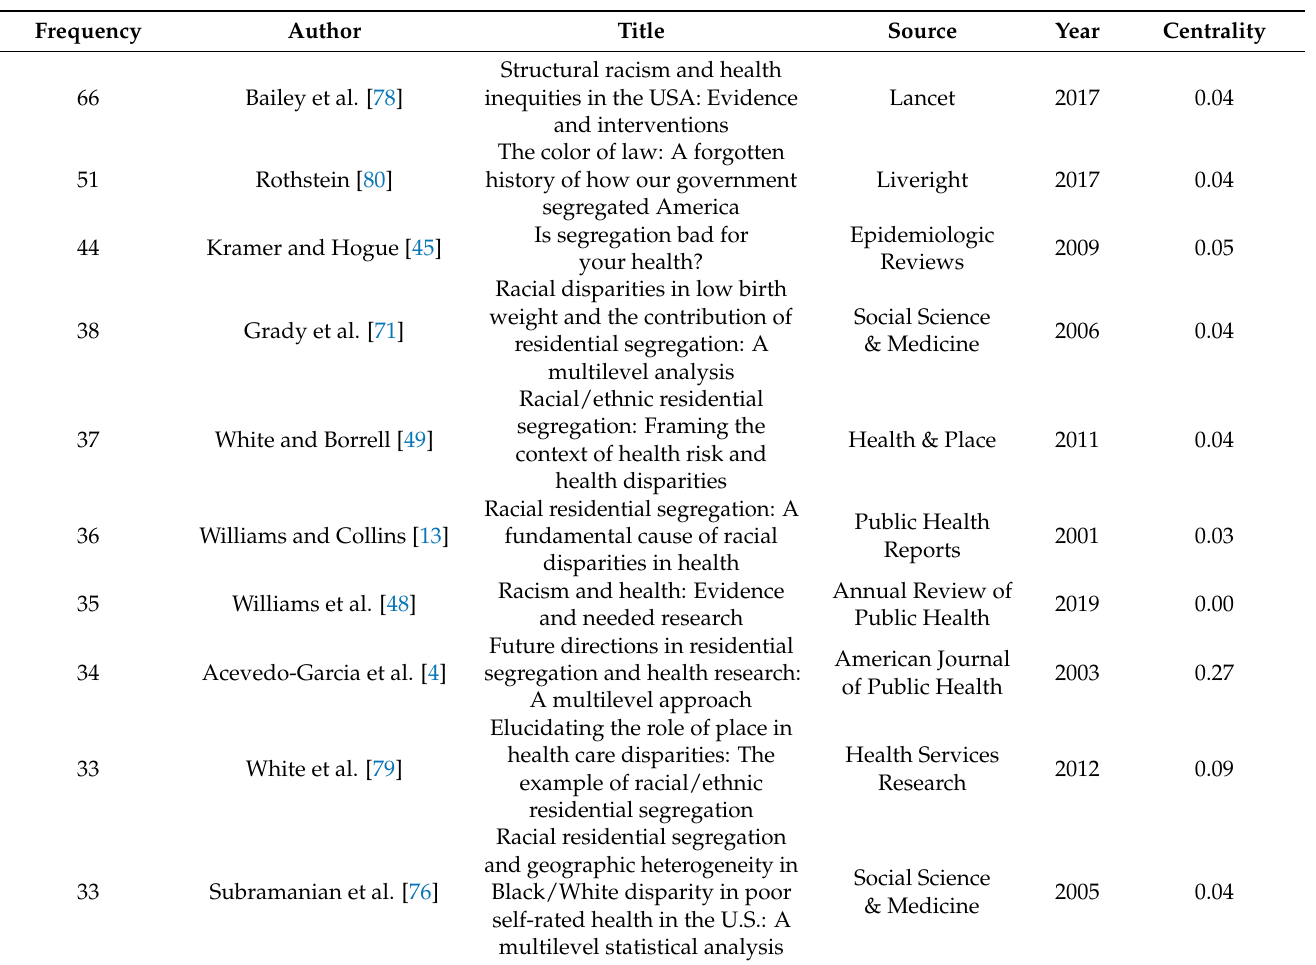
Table 4. Top 10 most highly cited references in RSH